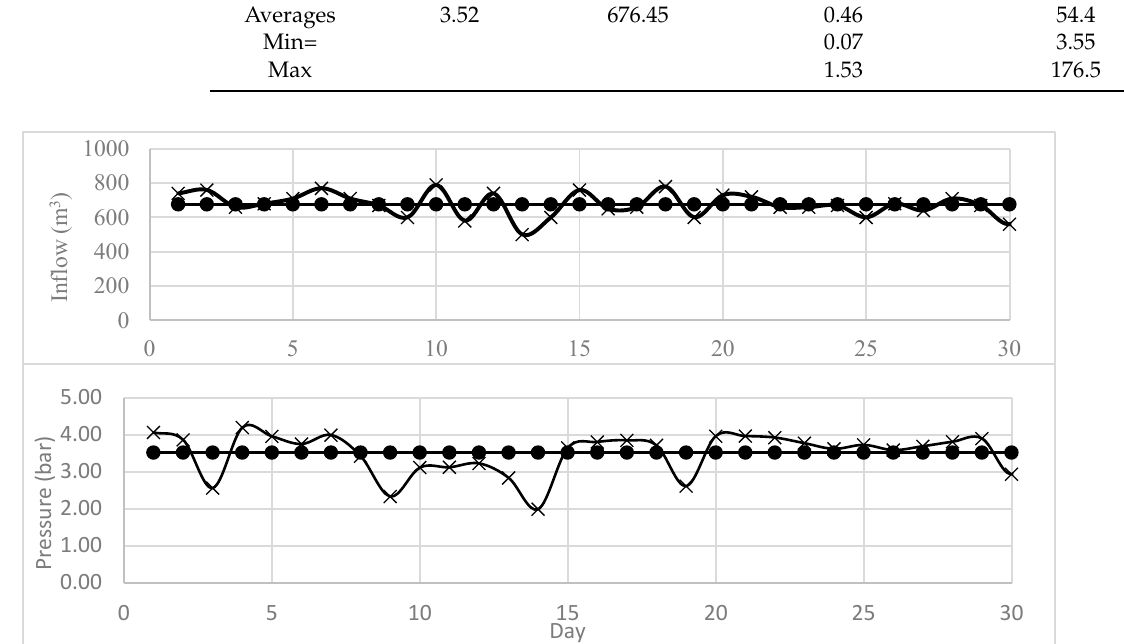
Figure 2. Flows (m 3 ) and pressures (bar) per day in DMA 1, the straight line represents the average. Degradation or drops in chlorine concentration might be associated with water loss and leakage. Leakage in the WDN can adversely affect the flow and pressure in the pipe- lines and have a detrimental effect on water quality. The chlorine level is usually higher near the source (desalination plants) in the WDN because the chlorine dosage is injected at this phase and then reduces in the later distribution stages. Several studies have used changes in water quality parameters and chlorine concentrations to detect leakages in the WDN [41,42]; thus, drops in chlorine are used in this study. Table 2 summarizes the drops in chlorine for the 13 DMA. Table 2. Drops in chlorine (CL) in ppm . DMA